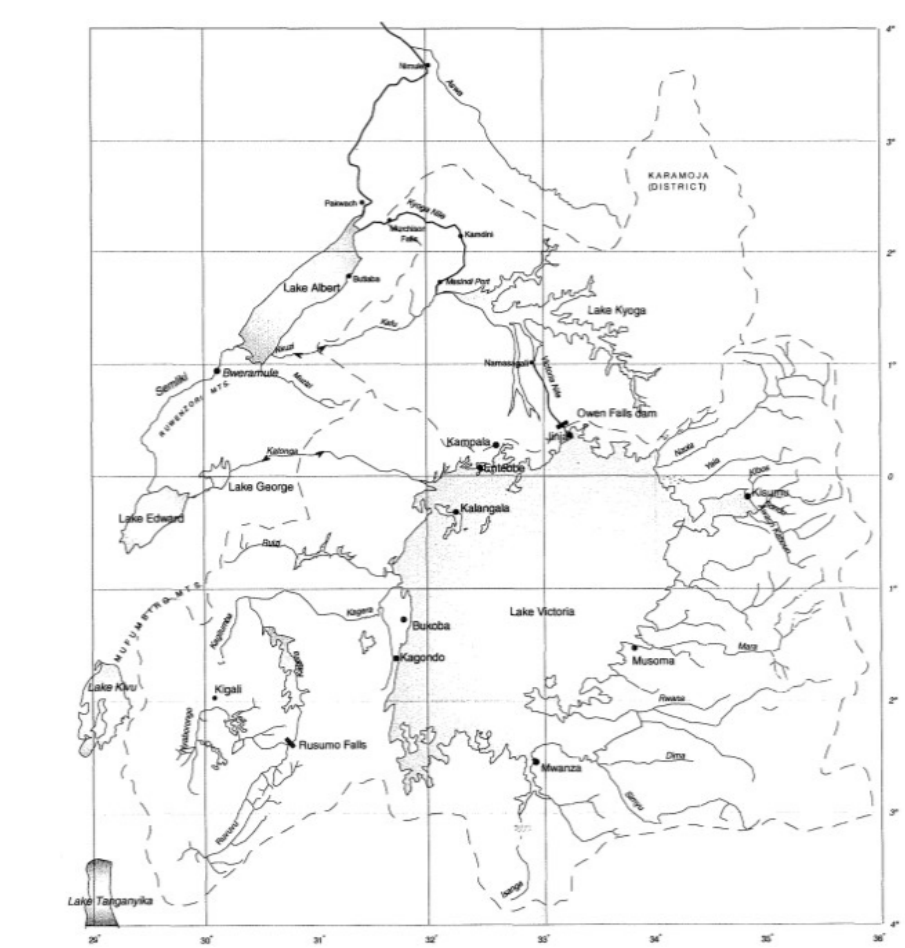
Figure 1. Map of the lake region (source: IAHS Press and Sutcliffe and Parks,